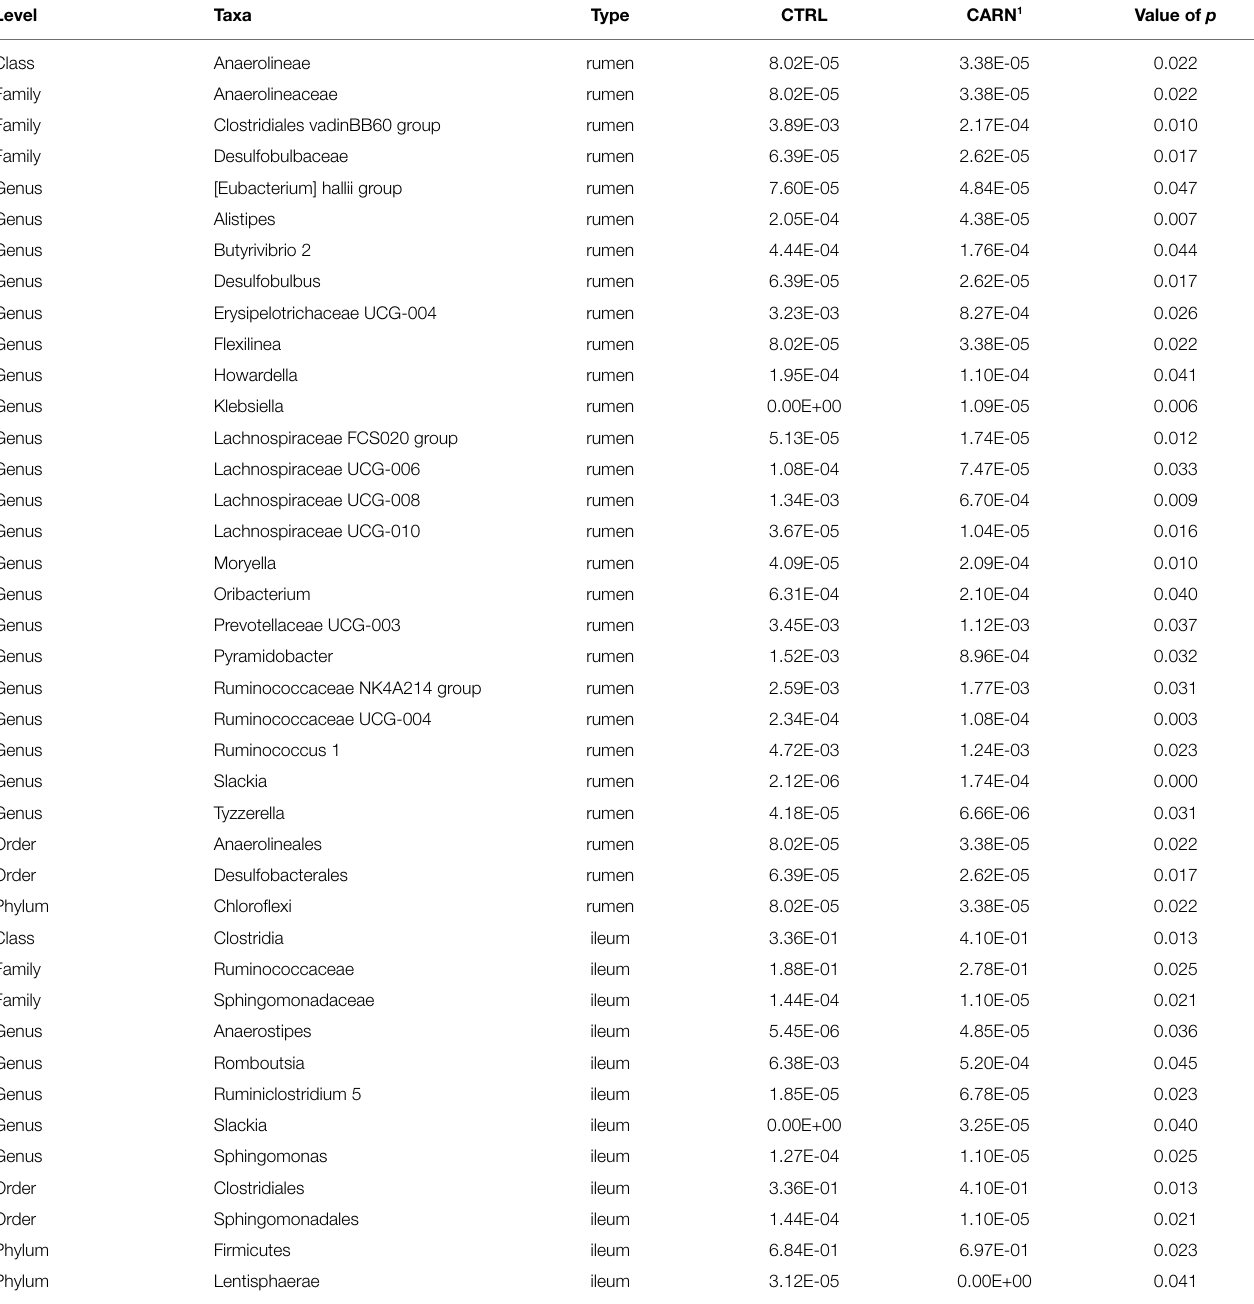
TABLE 7 | List of OTUs (ruminal and ileal compartments) with relative abundances significantly different in the early feed restricted lambs being fed the control (CTRL) or the L-Carnitine diet (CARN) during the fattening